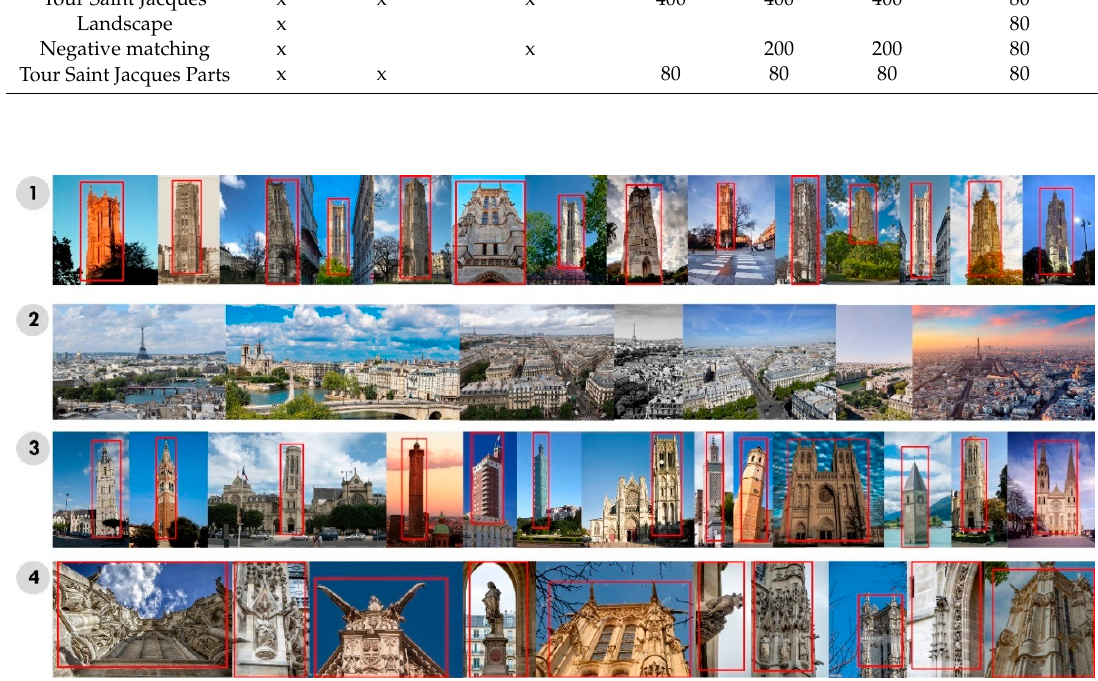
Figure 5. A selection of the pictures from the dataset 1: ( 1 ) Tour Saint Jacques; ( 2 ) landscape; ( 3 ) negative matching; ( 4 ) tower parts.